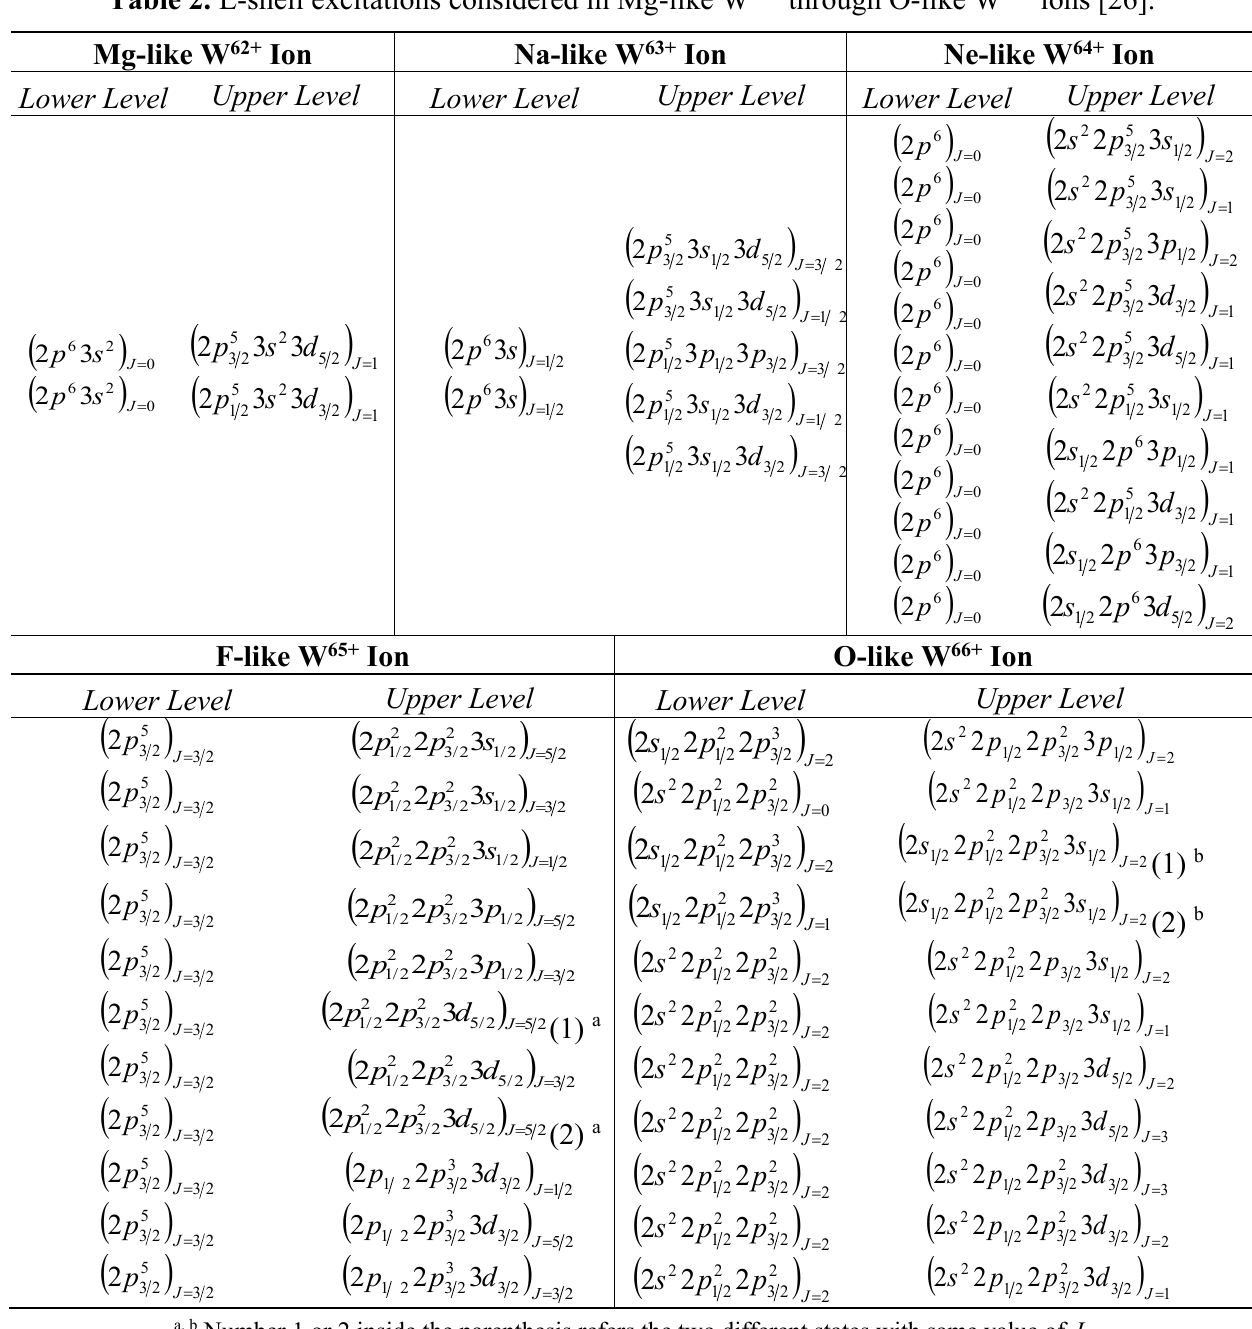
Table 2. L-shell excitations considered in Mg-like W 62+ through O-like W 66+ ions